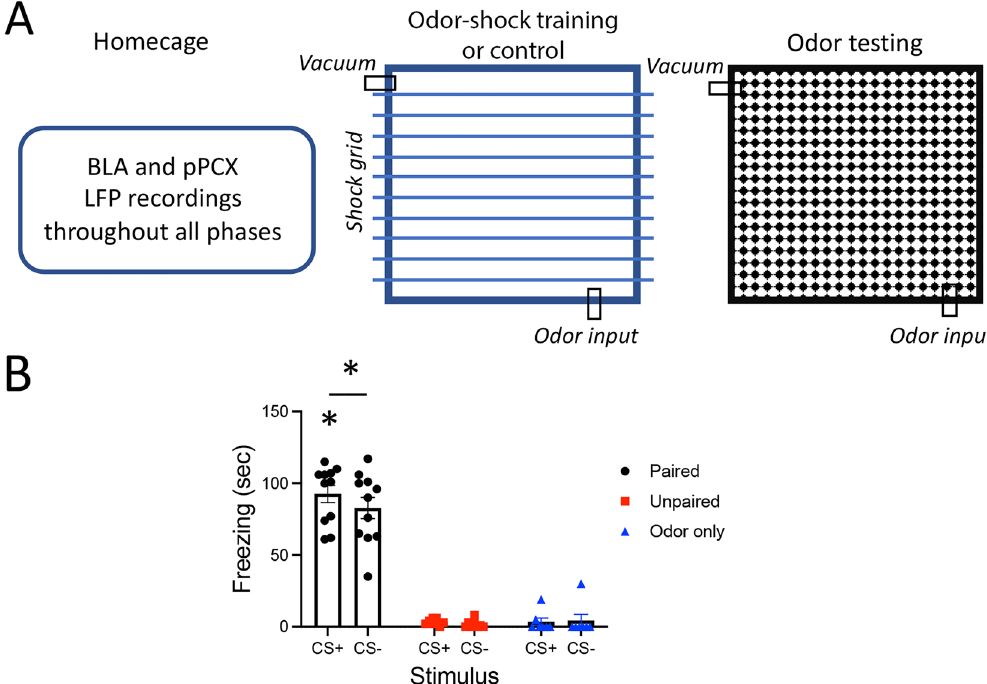
Figure 1. ( A ) Rats were implanted with electrodes in the BLA and pPCX for LFP recordings of odor-evoked and spontaneous local oscillations and BLA-pPCX coherence in the homecage, during odor-shock or control conditioning, and odor-evoked responses 24 h later in a different context. ( B ) Odor threat conditioning evoked freezing to the CS+ odor and significantly less freezing to the CS− odor (carat signifies CS+ evoked freezing was significantly more than CS− evoked freezing, p < 0.05). Paired animals froze significantly more than un-shocked Controls (asterisks signify p <